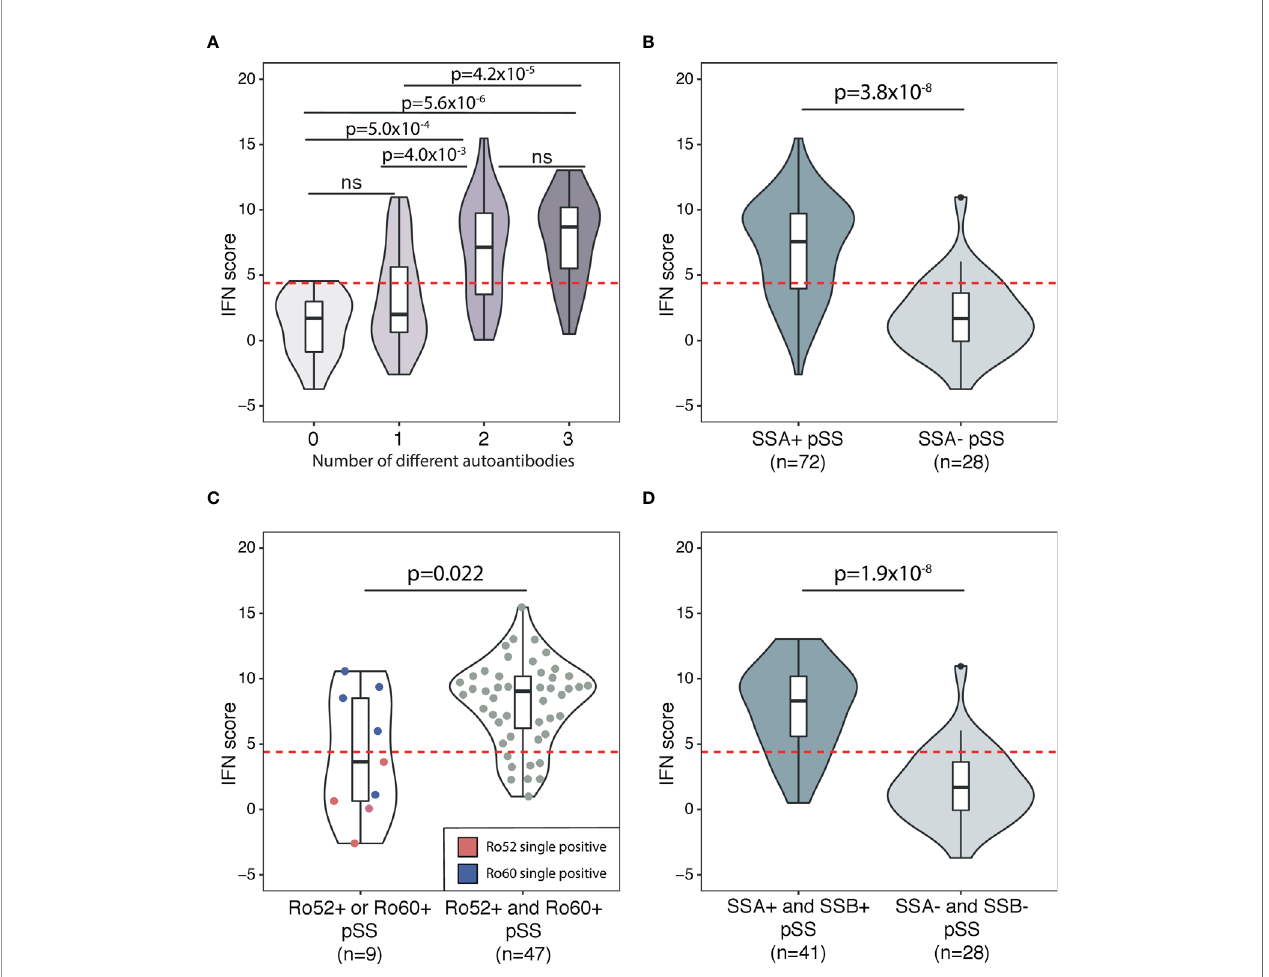
FIGURE 3 | Association between DNAm IFN score levels and different autoantibody pro fi les in patients with pSS in the discovery cohort. The threshold for high IFN score is indicated by the dotted red horizontal line in each graph. Boxes within the violins indicate median and interquartile range, whiskers indicate total range. (A) Association between DNAm IFN score and number of different autoantibodies in sera from patients with pSS. Autoantibodies included in the analysis were ANA, SSA and SSB. (B) IFN score in SSA positive pSS compared with SSA negative pSS. (C) SSA positive pSS patients strati fi ed for Ro52 or Ro60 single positivity (violin on the left with IFN scores of Ro52 single positive pSS indicated by red dots and Ro60 single positive pSS indicated by blue dots) compared with Ro52 and Ro60 double positive pSS (violin on the right with individual IFN scores of patients indicated by grey dots). (D) IFN score in SSA and SSB double positive pSS compared with SSA and SSB double negative pSS. (A) Kruskal-Wallis with post hoc Mann-Whitney U . (B – D) Mann-Whitney U